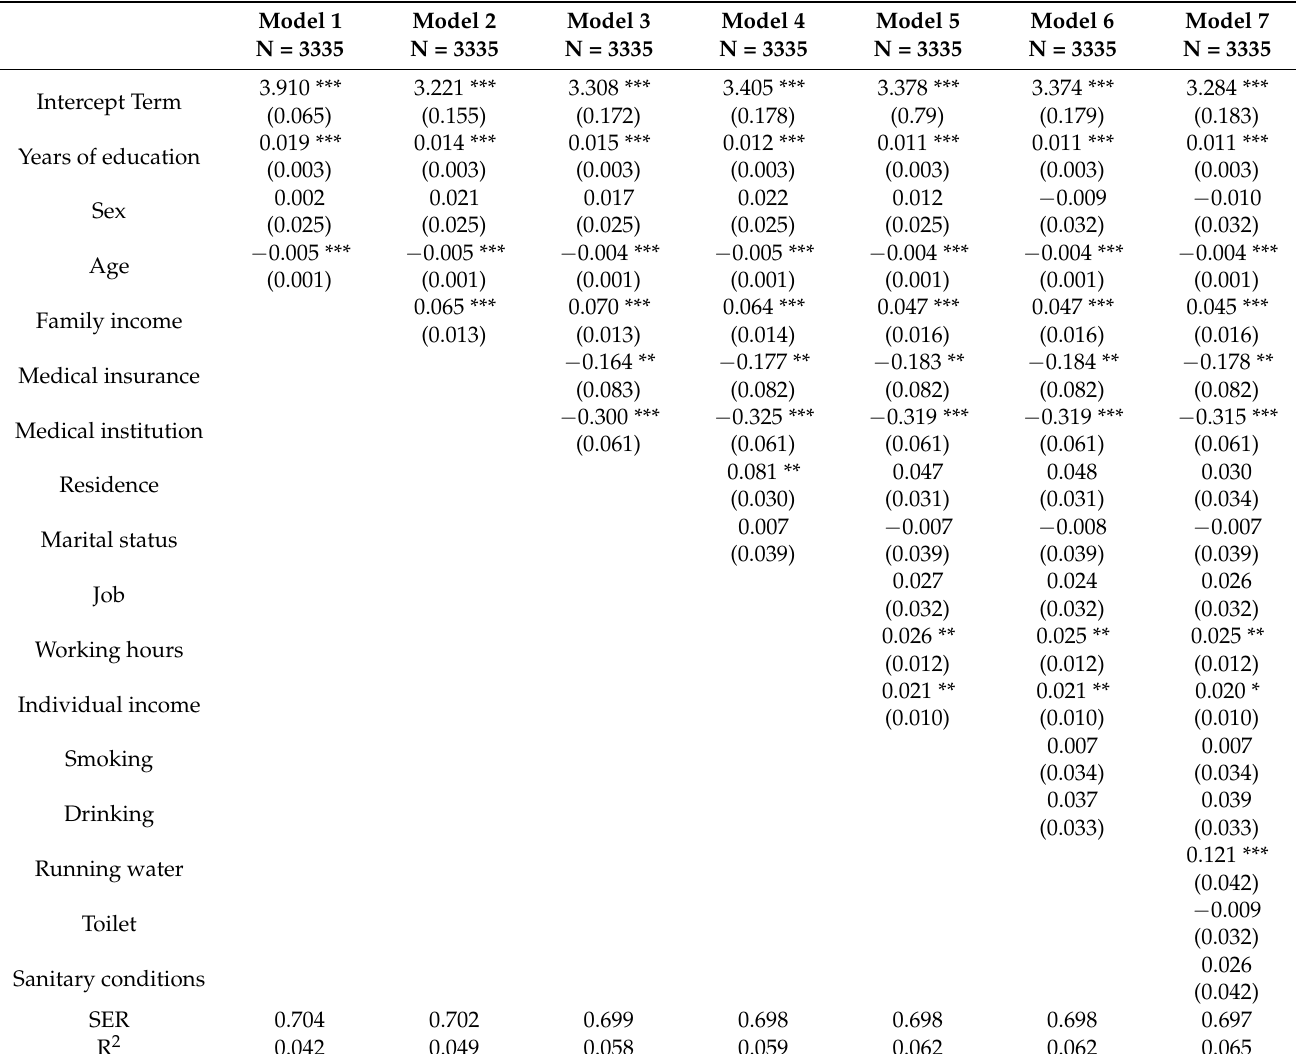
Table 2. Results of the impact of education, medical services, and living conditions on physical